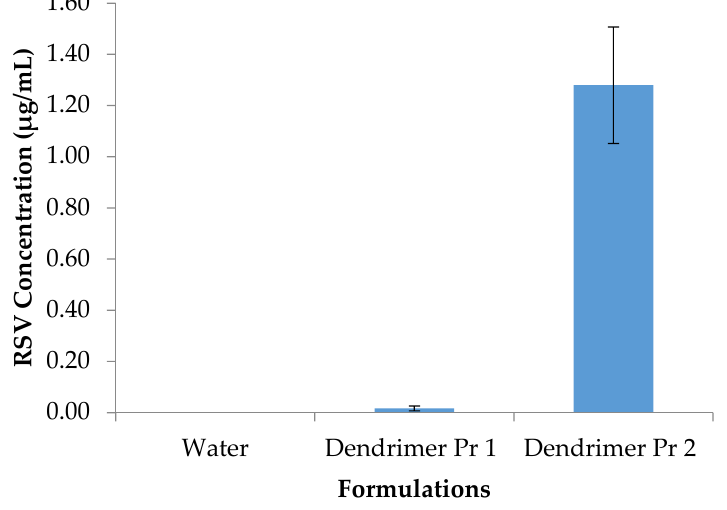
Figure 3. RSV solubility in water and with dendrimer formulations prepared by two different methods, Protocol 1 (Pr 1) and Protocol 2 (Pr 2). Dendrimer concentration 0.1% w / v . ( n = 3, p < 0.05).